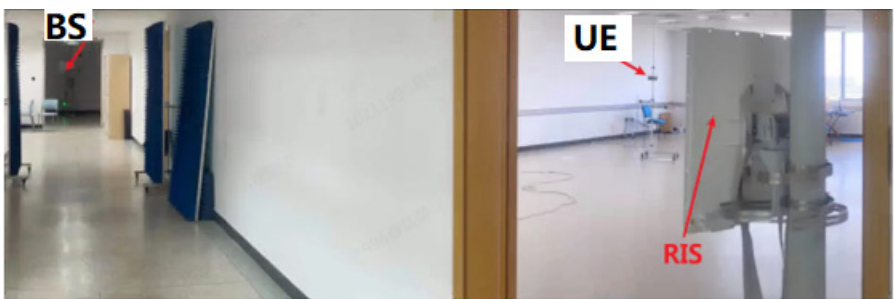
Figure 3. RIS panel indoor deployment.